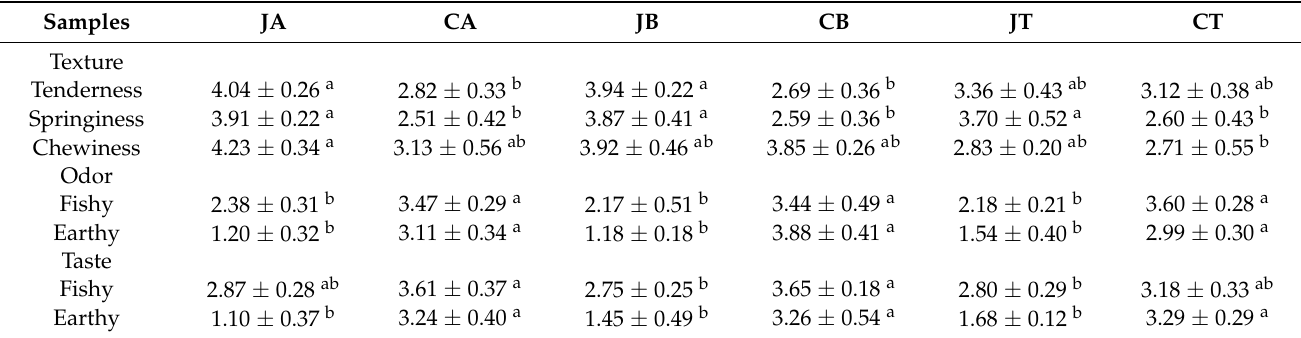
Table 5. Sensory evaluation in different parts of JPGC and